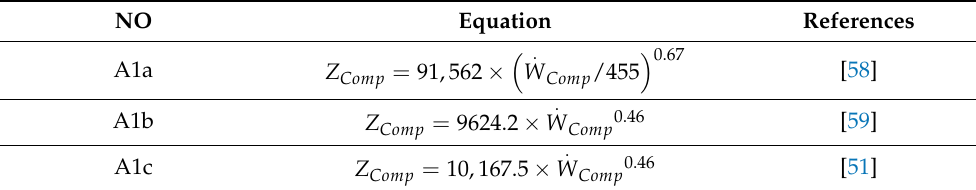
Table A1. Compressor purchasing cost